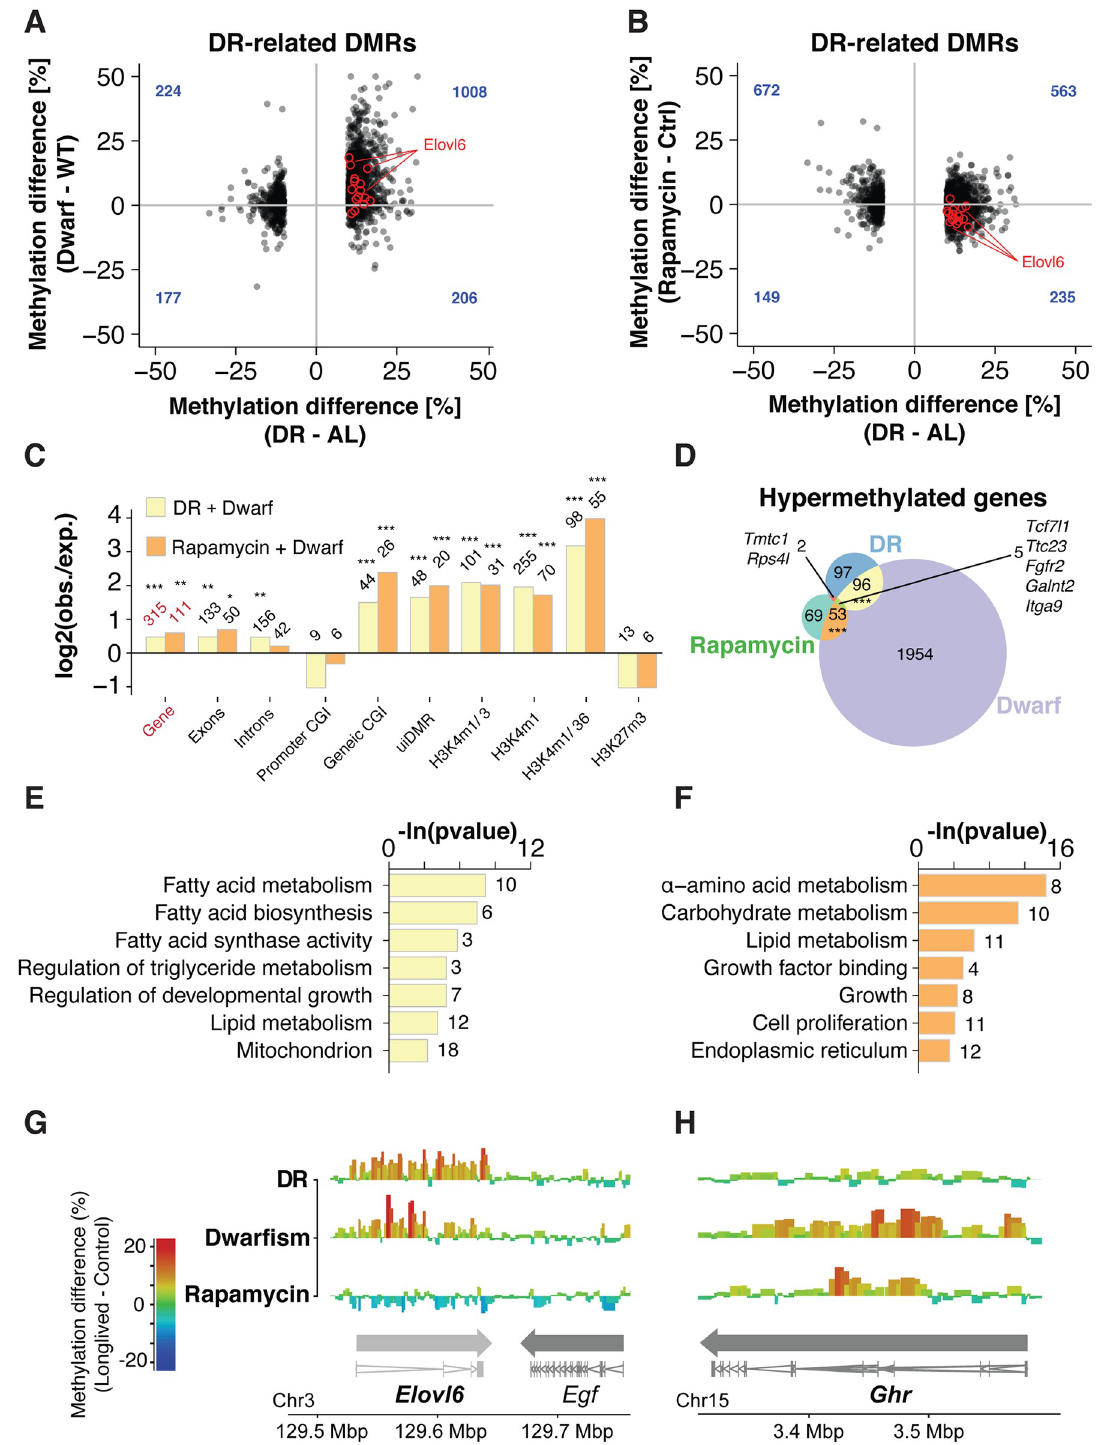
Fig 3. Conserved intervention-related remodeling of gene body methylation. (A, B) Scatterplot comparison of bin-wise methylation differences between DR-related DMRs versus changes in the same bins in Ames dwarf (A) and rapamycin-treated (B) mice, respectively. Bins overlapping the Elovl6 gene are highlighted in red. Methylation differences under DR were significantly positively associated with differences in Dwarfs (One-sided Fisher’s exact test p < 0.001) but not with rapamycin-treated mice. Number of bins in each quadrant is indicated in blue. (C) Enrichment analysis of common hypermethylated DMRs between DR and Dwarfs (n = 403) and